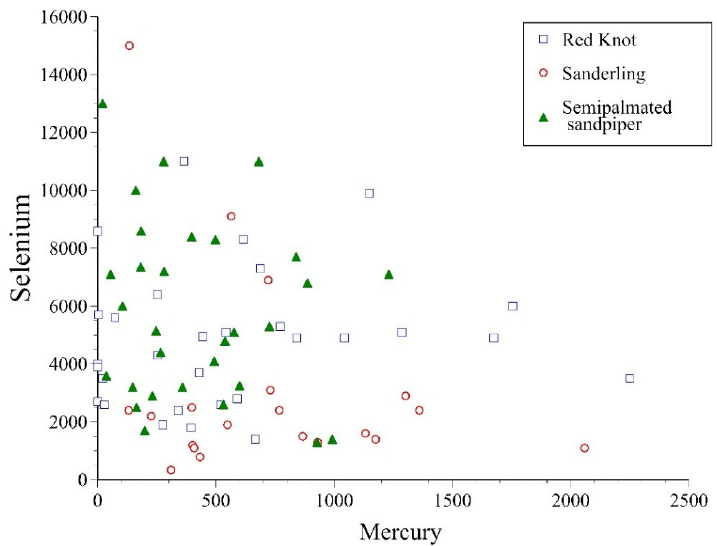
Figure 2. Mercury-selenium relationship in feathers of the three